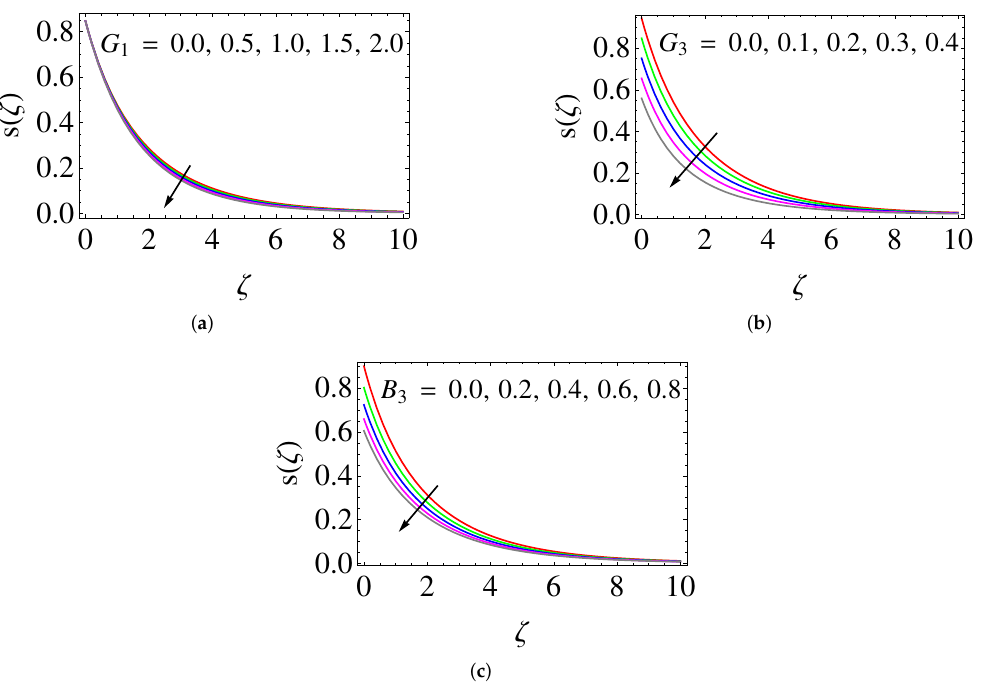
Figure 8. Influences of ( a ) thermal ( G 1 ) , ( b ) concentration ( G 3 ) stratification and ( c ) concentration slip ( B 3 ) parameters on concentration profile for M = 0.2, Rd = 0.1, Nt = 0.1, θ w = 0.1, Nb = 0.1, Pr = 1.4, D f = 0.2, Sc n = 1.9, Sc = 0.4, S r = 0.2, γ = 0.1, C r = 0.1, A = 0.1, G 2 = 0.1 and B 2 = 0.1.